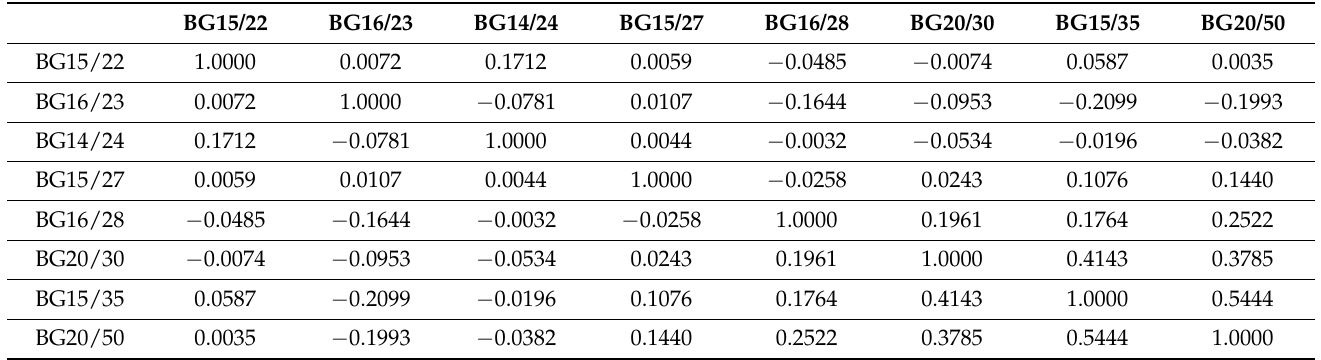
Table 6. YTM return correlation matrix of Bulgarian’s Sovereign Bonds.